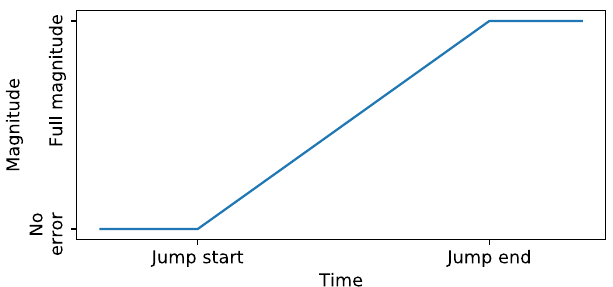
FIG. 4. Simplified flux jump event shape. It is modelled as a linear ramp toward the full amplitude of the jump. The duration of the ramp is on average 46 ms (506 turns in the LHC) for the flux jump on the magnetic field itself and 58 ms (638 turns in the LHC) for the reaction of the regulation